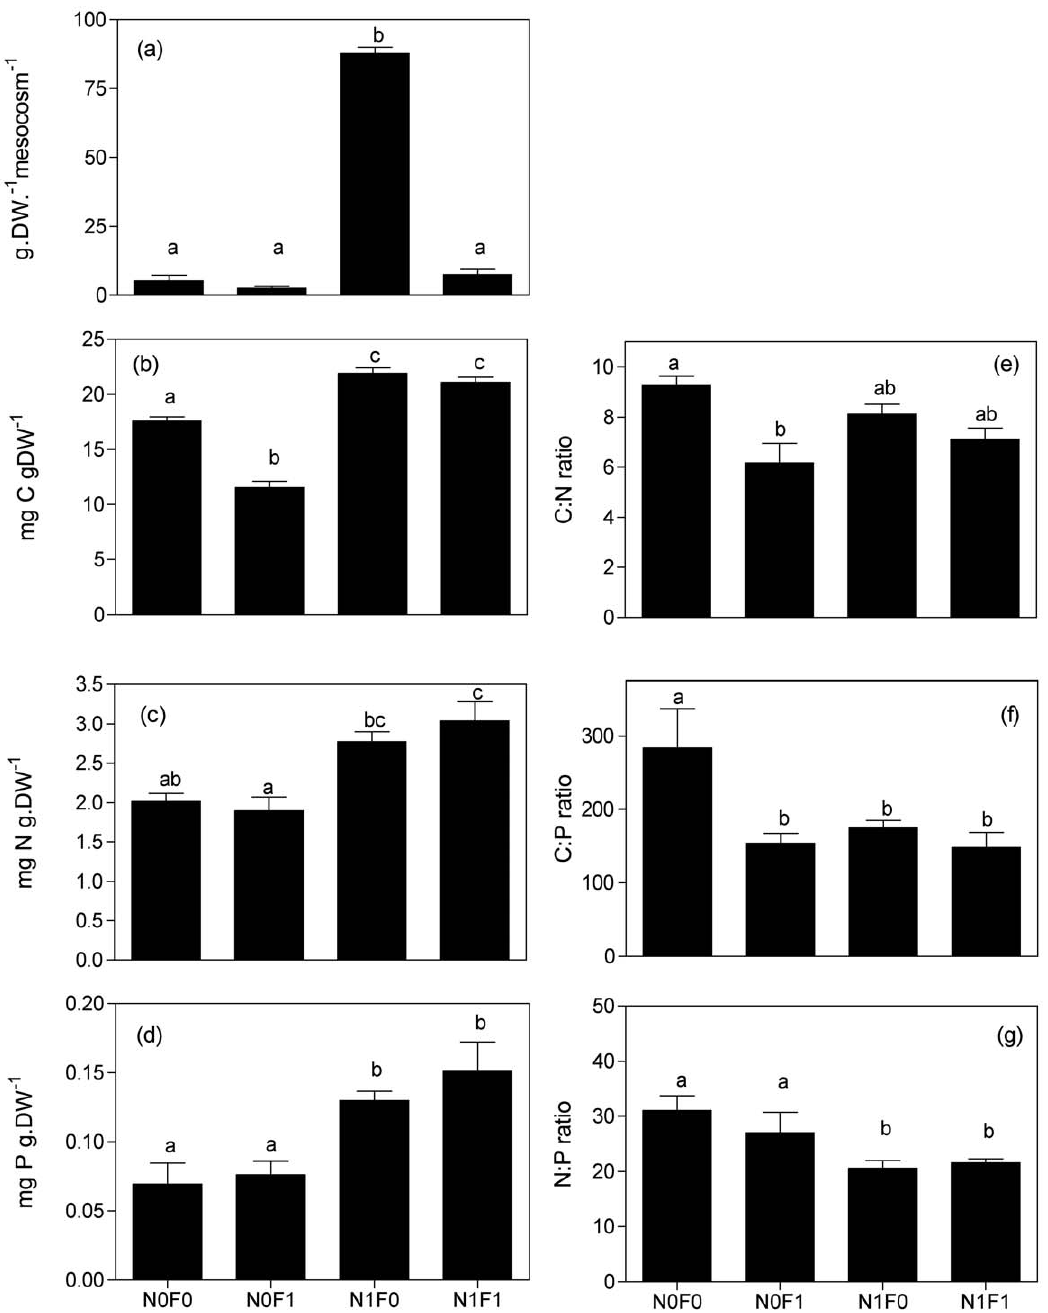
Figure 1. Biomass (a), Carbon content (b), Nitrogen content (c), Phosphorus content (d) and C:N (e), C:P (f) and N:P (g) molar ratios of Biomphalariatenagophila (Gastropoda). Treatments are represented by different nomenclatures (N0F0 (no fish or nutrients addition); N0F1 (only fish addition); N1F0 (only nutrients [N and P] addition); N1F1 (both nutrients and fish addition). Each bar represents mean values + 1SE. Different letters above bars represent significant statistical differences (Two-way ANOVA with Contrast Analysis as post hoc test, P ,